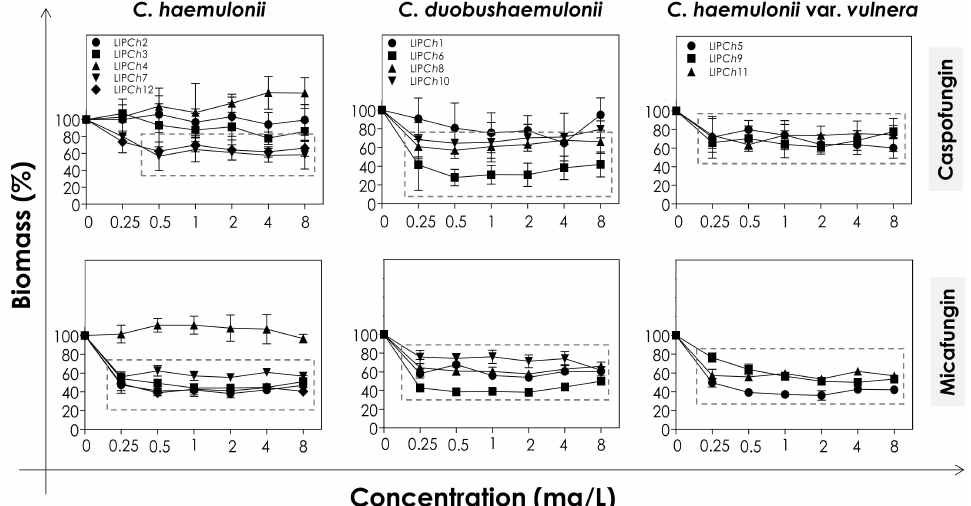
Figure 2. Biomass of biofilms formed by clinical isolates comprising the C. haemulonii species complex exposed to di ff erent concentrations of echinocandins (caspofungin and micafungin). The amount of crystal violet incorporated by the cells was assessed spectroscopically (absorbance at 590 nm) and the results expressed as the mean of biomass percentages compared to untreated biofilms (control), which correspond to 100%. The graphs show the mean ± standard deviation of three independent experiments. The dashed boxes represent the concentrations of echinocandins that caused a statistically significant reduction in biomass in relation to the respective control ( p < 0.05; One-way ANOVA analysis of variance, Dunnett’s multiple comparison